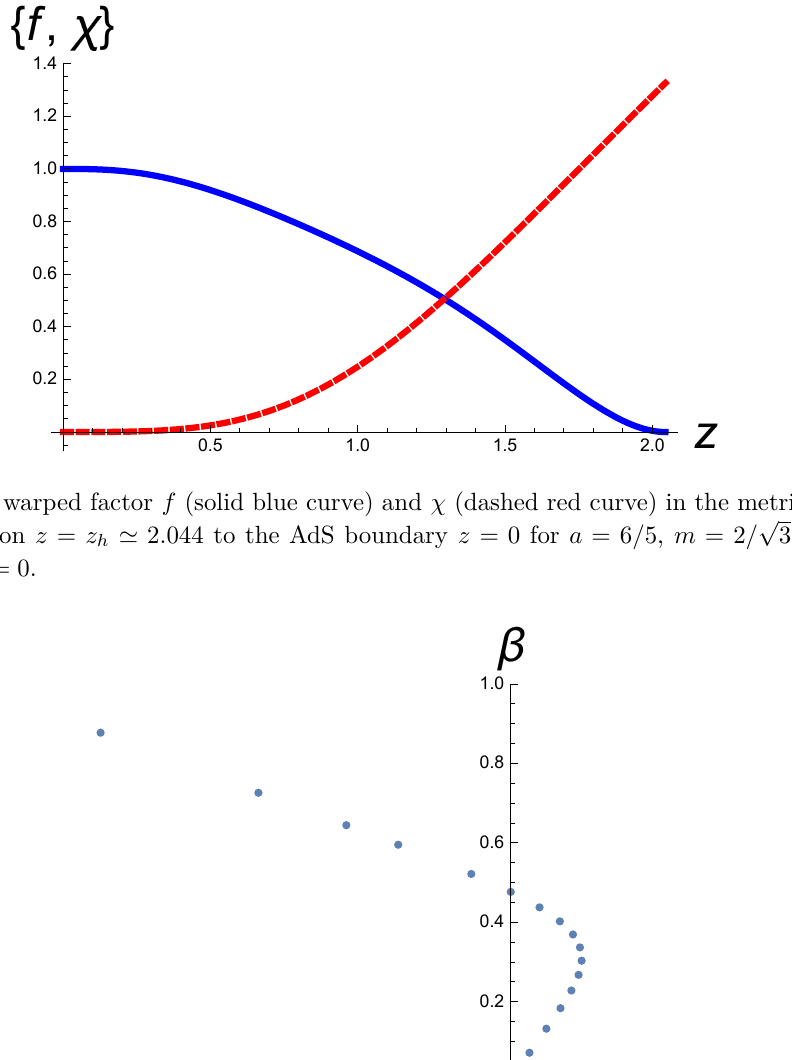
Figure 3 . α - β plot for a = 6 / 5 , m = 2 /